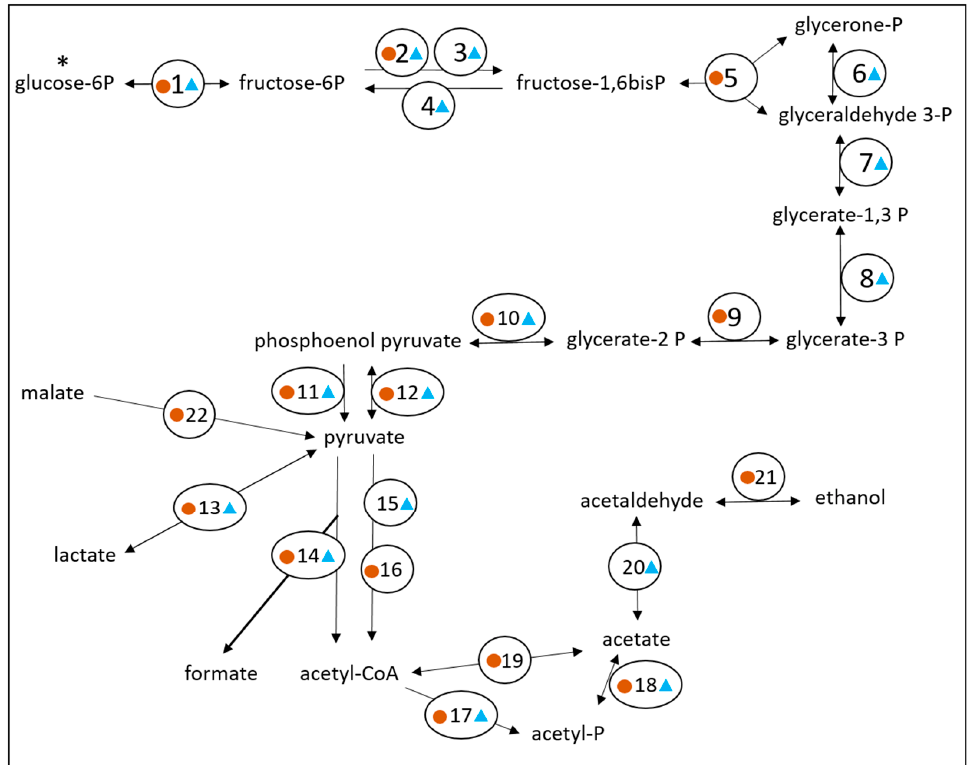
Figure 2. Proposed glycolytic pathway for Bt-01708_Bf and Bt-01899_Ap. Coding sequences for enzymes identified in the Bt-01708_Bf contig set are labeled with a brown circle, while coding sequences for enzymes identified in the Bt-01899_Ap contig set are labeled with a blue triangle. As the metagenomics analysis revealed PTS systems, while hexokinases were not found (Supplemental File S4), the pathway is shown as starting with glucose-6P (*). Key for enzyme legend: (1) glucose-6-phosphate isomerase (EC 5.3.1.9); (2) 6-phosphofructokinase (EC 2.7.1.11); (3) pyrophosphate-dependent fructose 6-phosphate-1-kinase (EC 2.7.1.90); (4) fructose-1,6-bisphosphatase (EC 3.1.3.11); (5) aldolase (EC 4.1.2.13); (6) triosephosphate isomerase (EC 5.3.1.1); (7) glyceraldehyde-3-phosphate